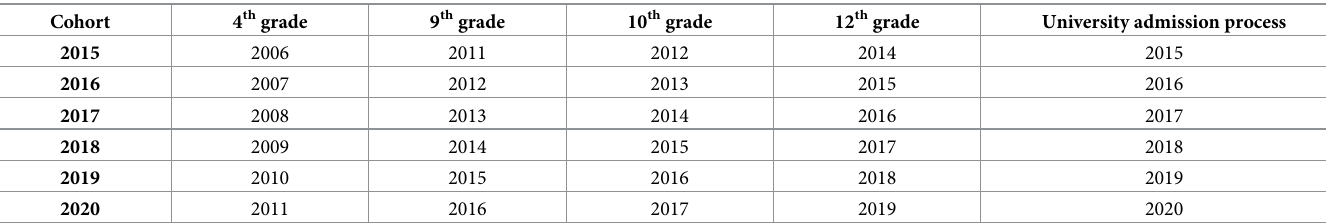
Table 1. Cohorts of students